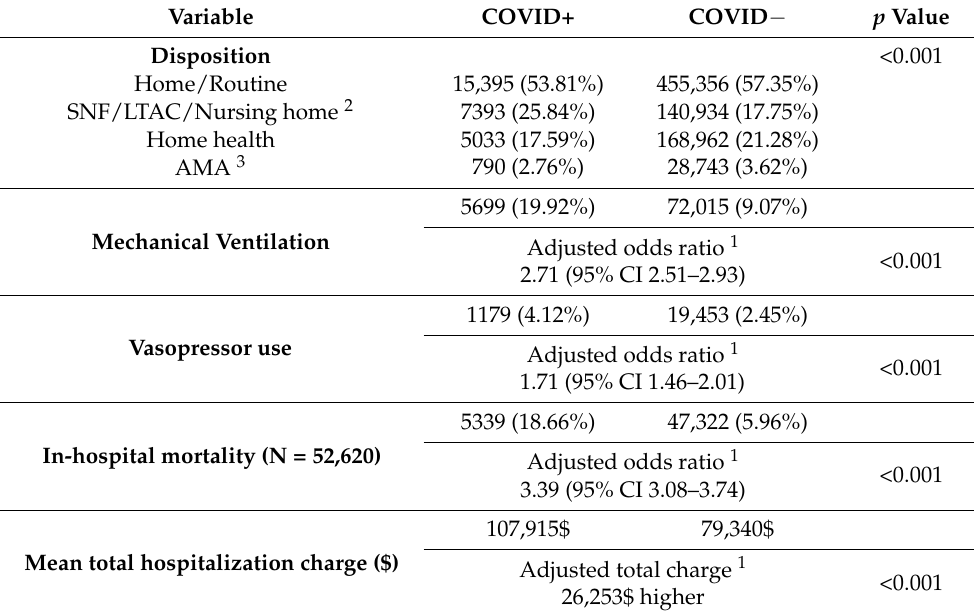
Table 2. In-hospital outcomes in COVID + and COVID—patients with